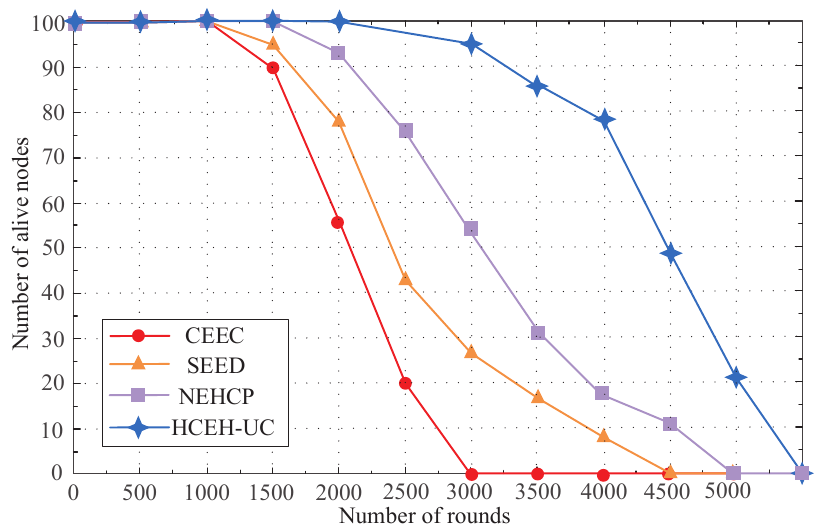
Figure 4. Number of alive sensor nodes per round for different routing protocols.